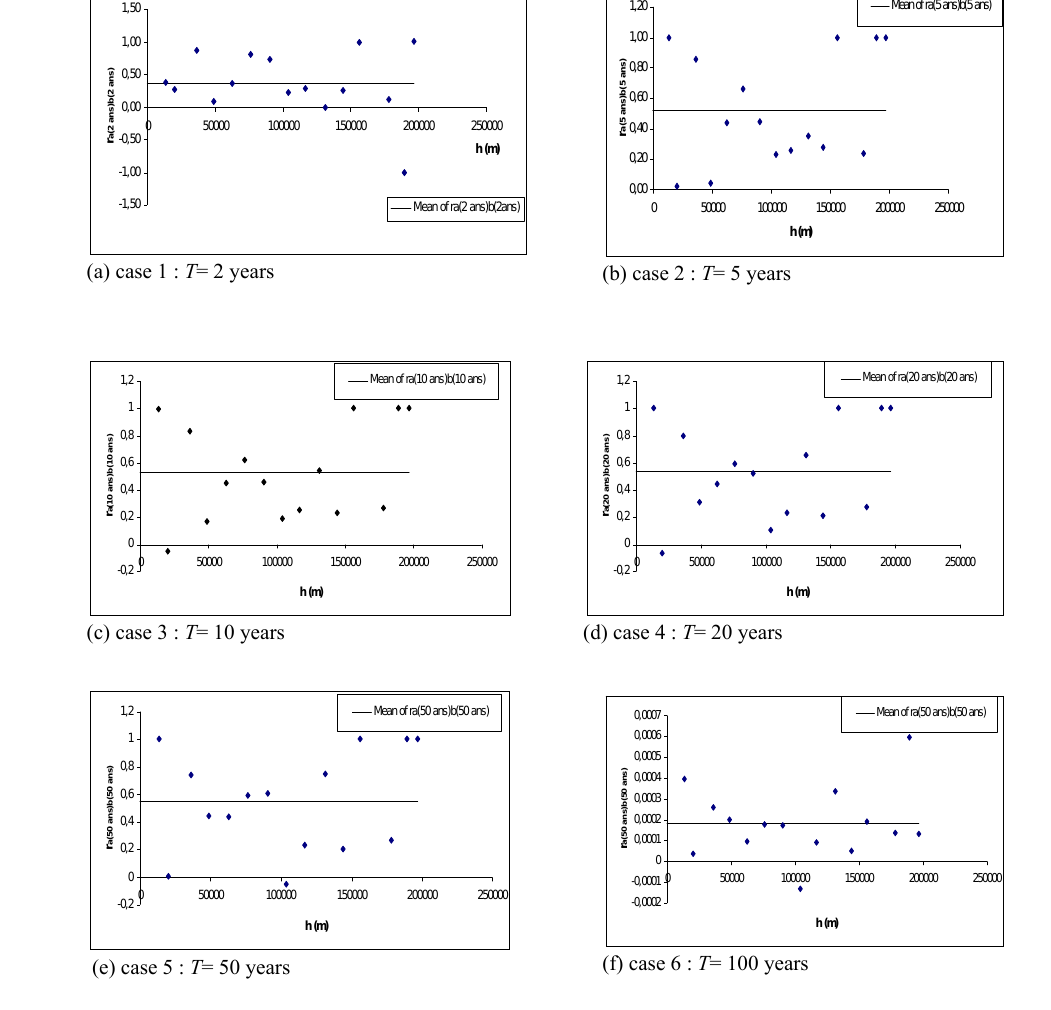
Fig. 2. Fluctuation of r a(T)b(T) (h)